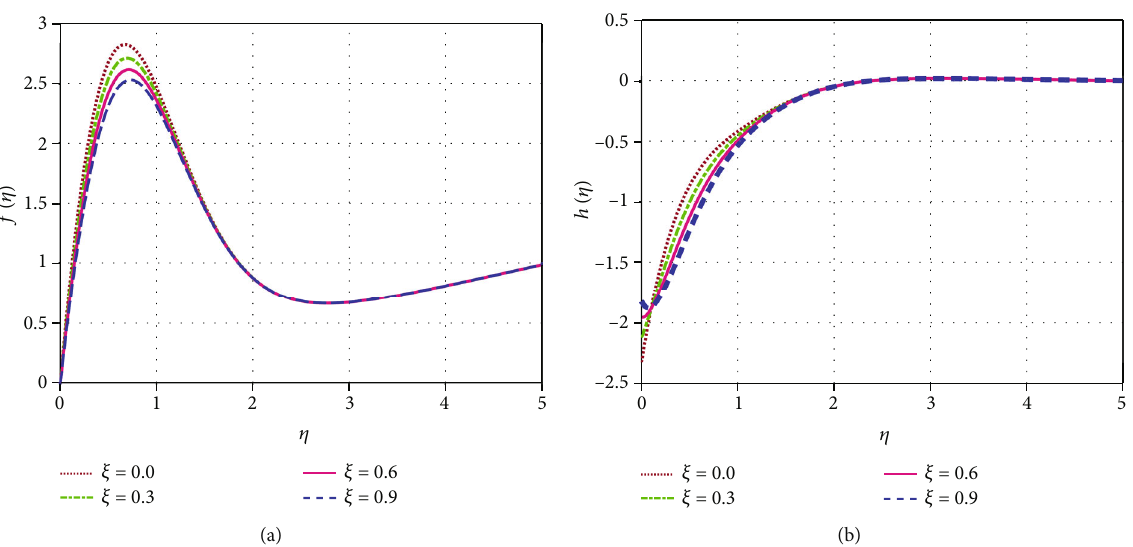
Figure 8: (a) Velocity, and (b) micro-rotation pro fi les for viscosity variation with γ = 45 ° , M =2, c =0.5, R =0.5, Pr =0.71, Sc =0.22, =0.33, λ = 1, K =0.5, Gr =10, and Gc L 1 1